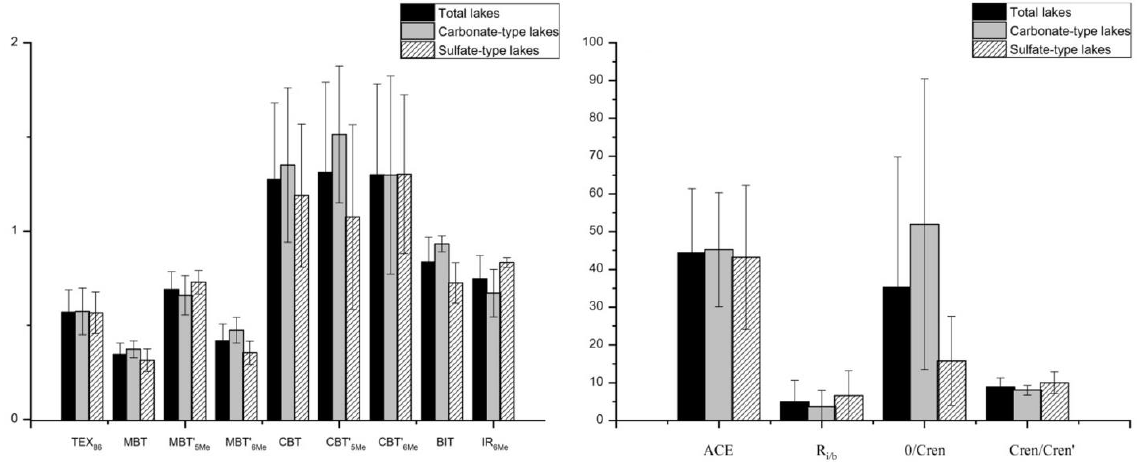
Figure 4. GDGT-based indices for the 13 surface